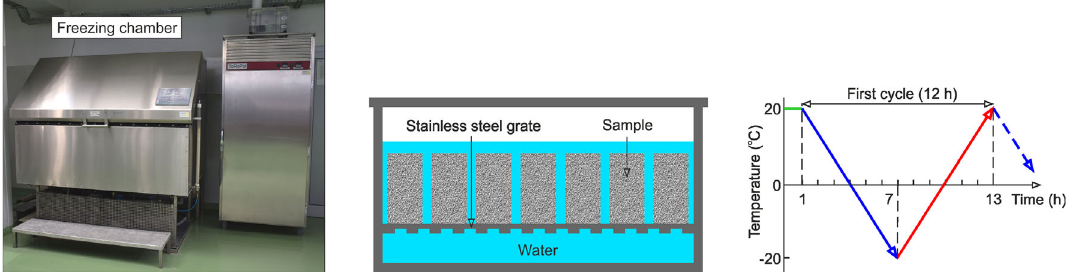
Fig. 2 Experimental set-up, schematic diagram, and cyclic temperature scheme for freeze–thaw test.